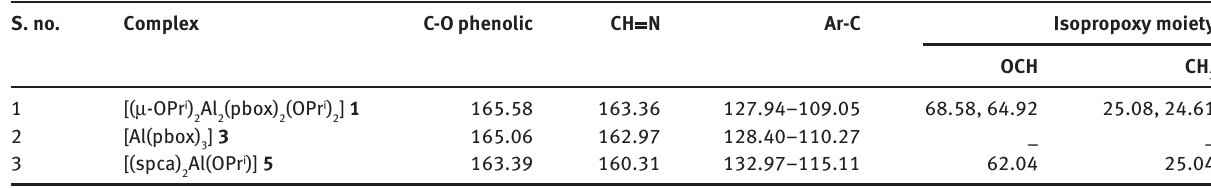
Table 4: 13 C NMR data (ppm) for aluminium(III) complexes 1, 3 and 5 . S.